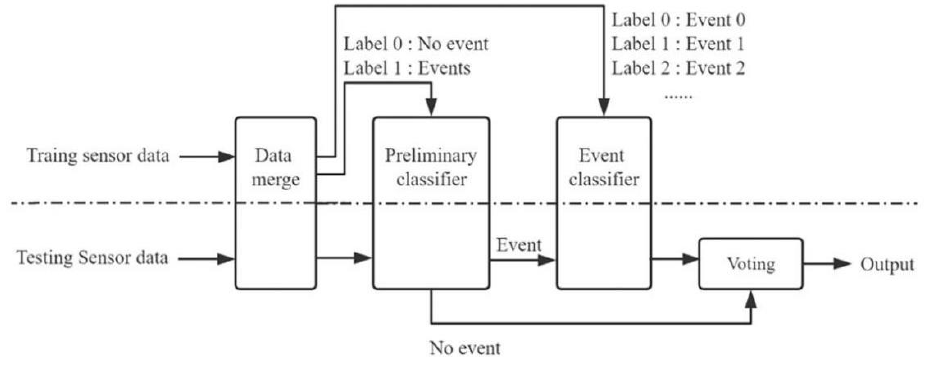
Figure 28. The diagram of the event recognition system [95].